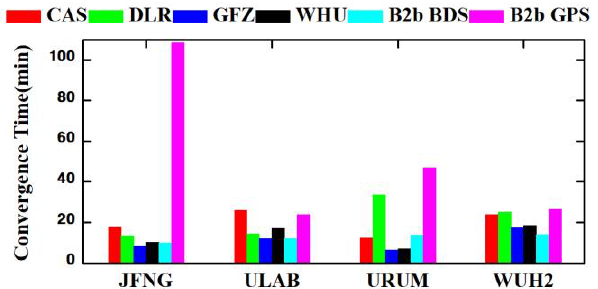
Figure 8. Convergence time of static dual-frequency PPP using different real-time orbit and clock products.